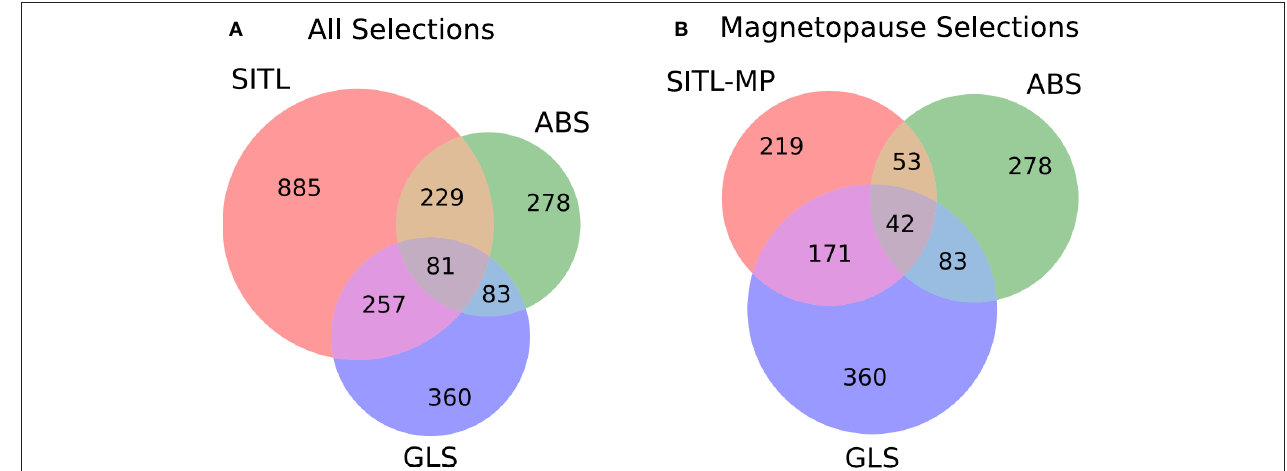
FIGURE 5 | A comparison of SITL, GLS, and ABS segments from SROI1 that takes into account the range-based nature of event selection intrinsic to time series data. (A) Considers all SITL selections whereas (B) includes only SITL-classified magnetopause selections.